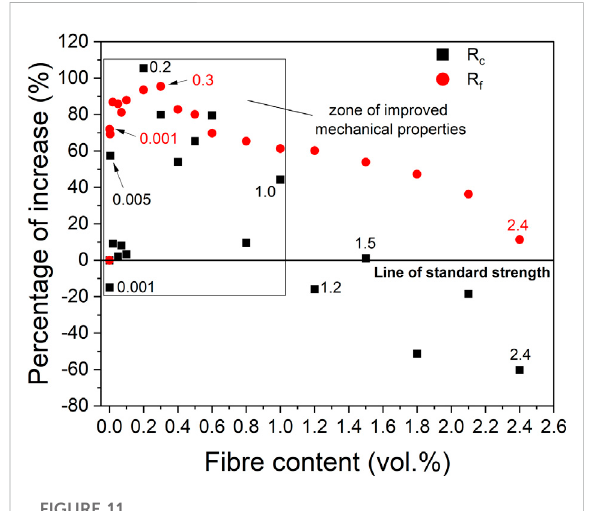
FIGURE 11 Percentage change in the mechanical performances R c and R f of smart cement-based composites at fi bre contents 0 – 2.4 vol % relative to the plain mortar (marked as line of standard